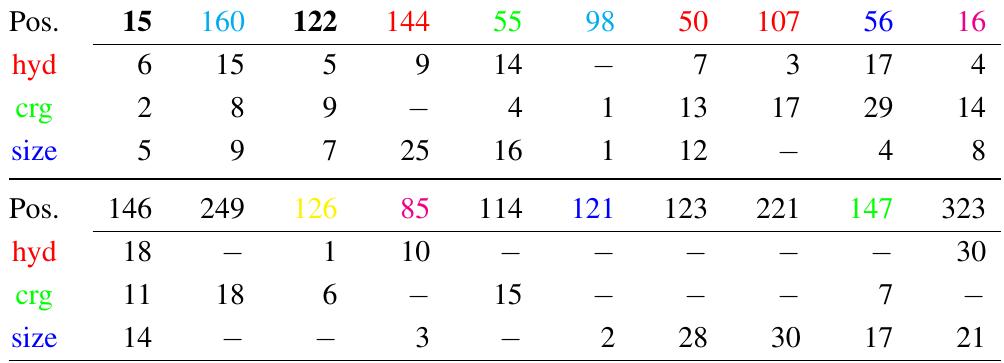
Table 4. Substitution class based runs over SDPs relevant within the LacI family. Ranks and colors as in Table 2.